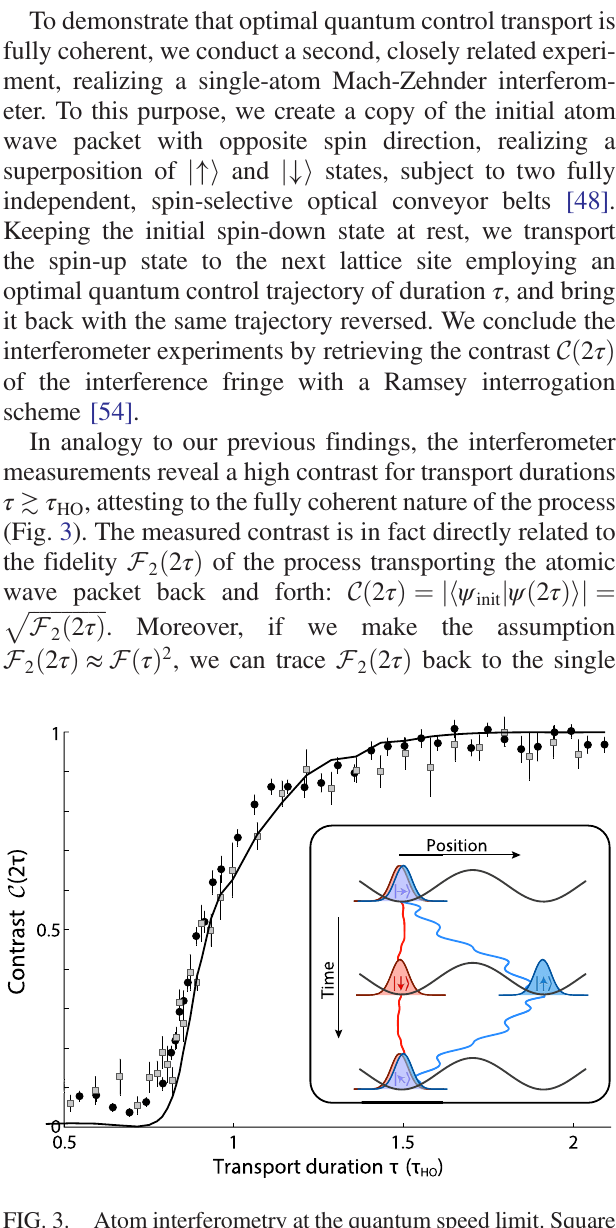
FIG. 3. Atom interferometry at the quantum speed limit. Square points: measured contrast C ð 2 τ Þ of the atom interferometer of duration 2 τ , with the atom in j ↑ i being transported with optimal quantum control back and forth. Circle points: measured fidelities F ð τ Þ from Fig. 2, reproduced here for comparison. Solid line: expected contrast obtained from numerical simulations assuming T ≈ 1 μ K. Error bars represent one standard deviation. Inset: the ⊥ blue and red lines describe the movement of the spin-up and spin- down conveyor belts, ensuring that the atom in spin-down state remains effectively at rest, since the two spin-dependent poten- tials are not fully decoupled (Appendix